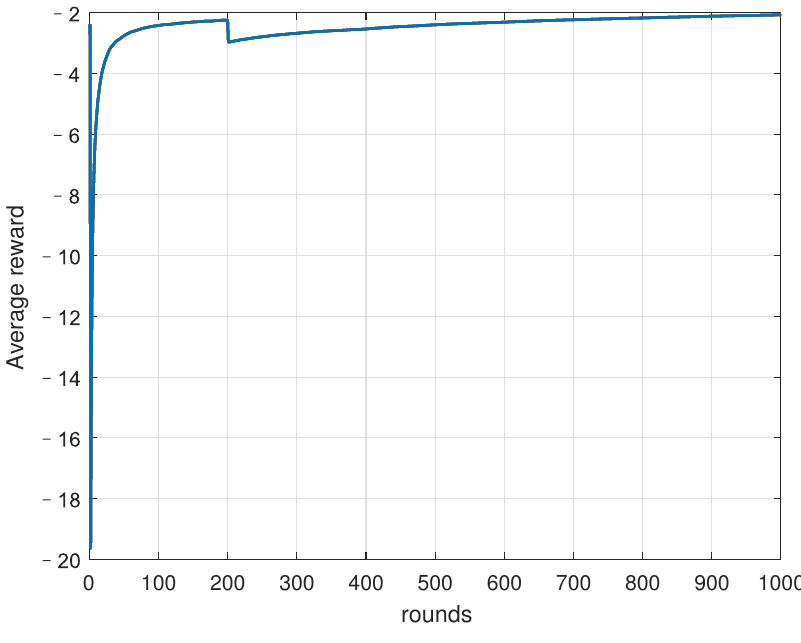
Figure 9. Average